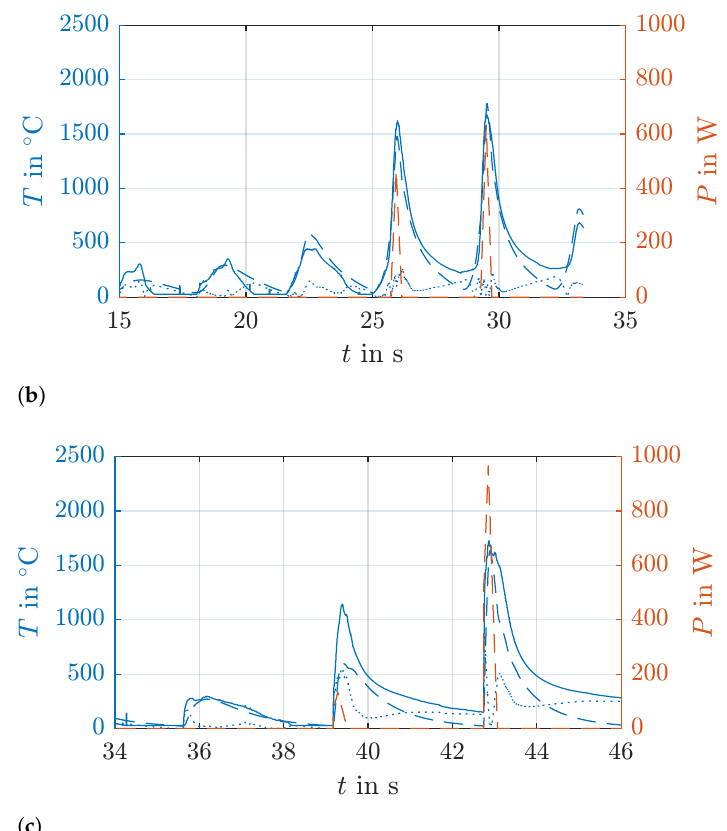
Figure 15. Time series for multiple tracks case at spatial instances ( s 1 , s 2 ) = { ( 3,3 ) , ( 7,7 ) } on training and ( s 1 , s 2 ) = ( 12,12 ) on validation data. Left axis (blue): Observed temperature y (solid line), predicted temperature ˆ y (dashed line), and absolute value of residual (cid:101) (dotted line). Right axis (red): Corresponding laser power. ( a ) Time series at spatial instance (3,3) on training data; ( b ) Time series at spatial instance (7,7) on training data; ( c ) Time series at spatial instance (12,12) on validation